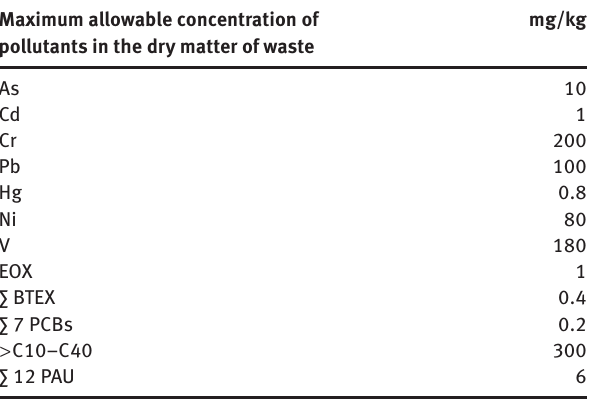
Table 1: Requirements for the content of pollutants in C&DW according to Decree No. 294/2005.